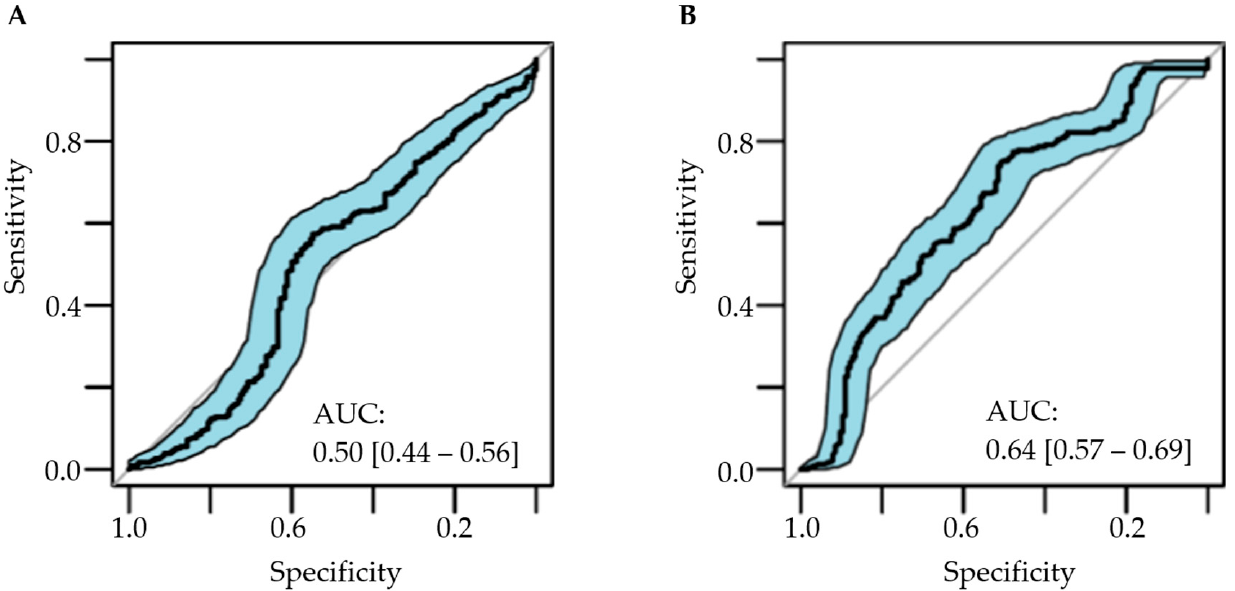
Figure 4. Discriminative capacity of ( A ) the RALE score and ( B ) the CTSS for ICU mortality. Shaded areas show 95% confidence intervals. Abbreviations: AUC: area under the curve; RALE: Radiographic Assessment of Lung Edema; CTSS: Chest CT Severity Score.